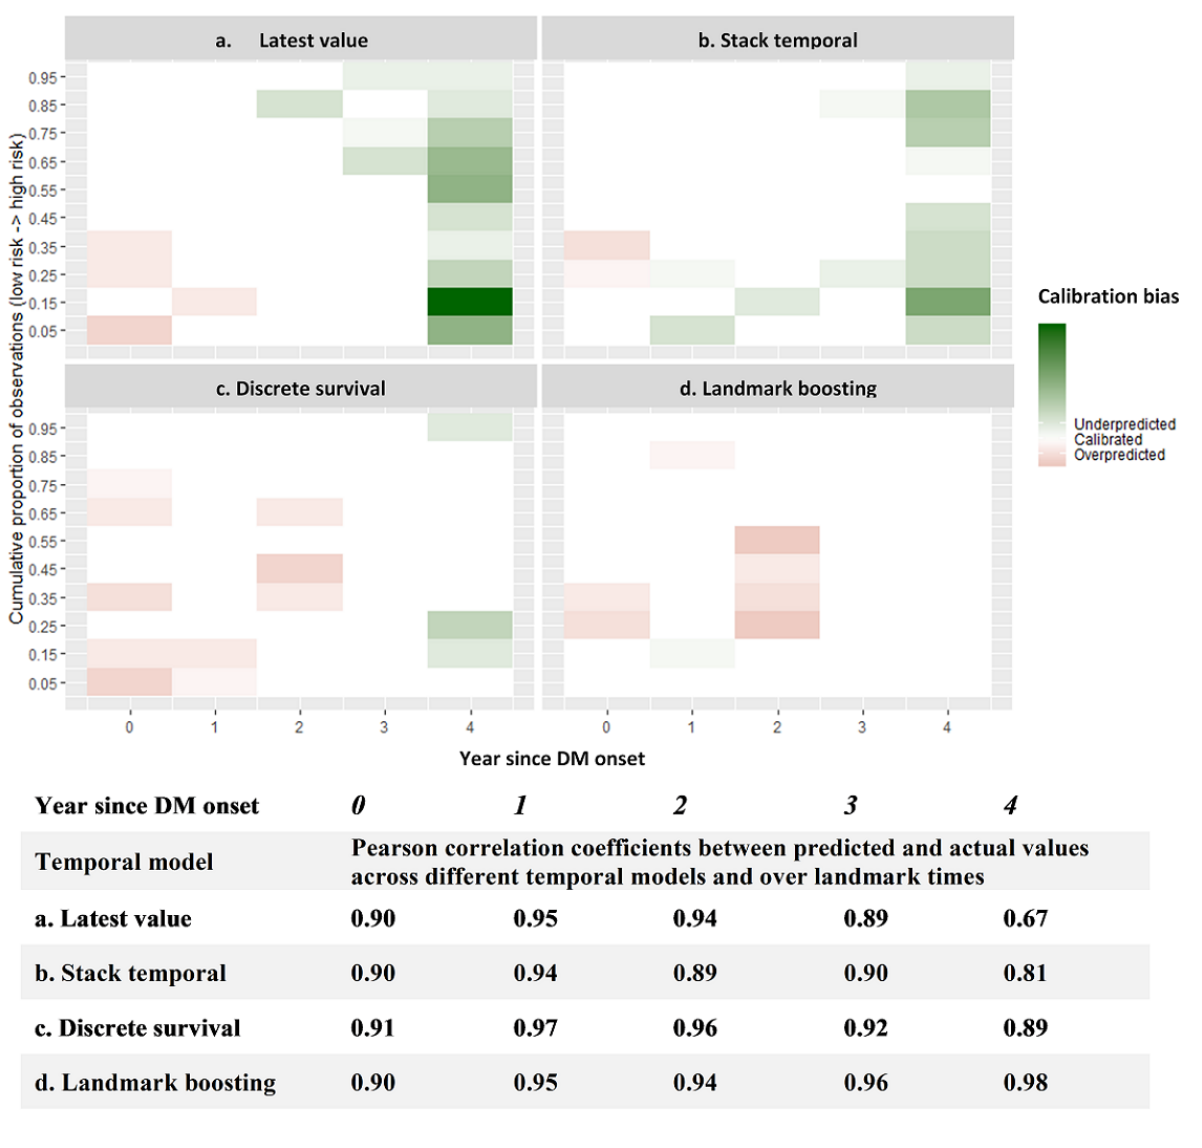
Figure 6. Calibration comparisons among temporal approaches over landmark time. Regions of calibration across the range of predicted probabilities, scaled by proportion of observations in each region and shaded by the magnitude of the within-region observed-to-expected ratio (O:E), with green suggests underprediction (ie, O:E significantly less than 1), and red suggests overprediction (ie, O:E significantly larger than 1). Pearson correlation coefficients between predicted and actual values over landmark times for each temporal model are included in the table below (the closer the coefficient is to 1, the better the predicted and actual values are linearly related). DM: diabetes